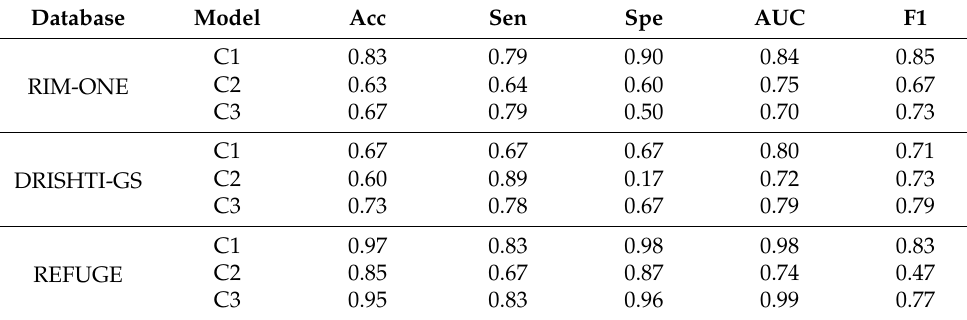
Table 1. Results for the models trained separately on each database.